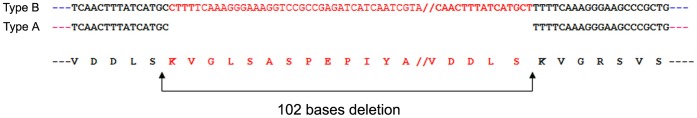
Sequencing analysis of both Type A and Type B cagA 3′end amplicon of PG157 showed the deletion of 102-bp in type A strains, which contained one “EPIYA” motif.